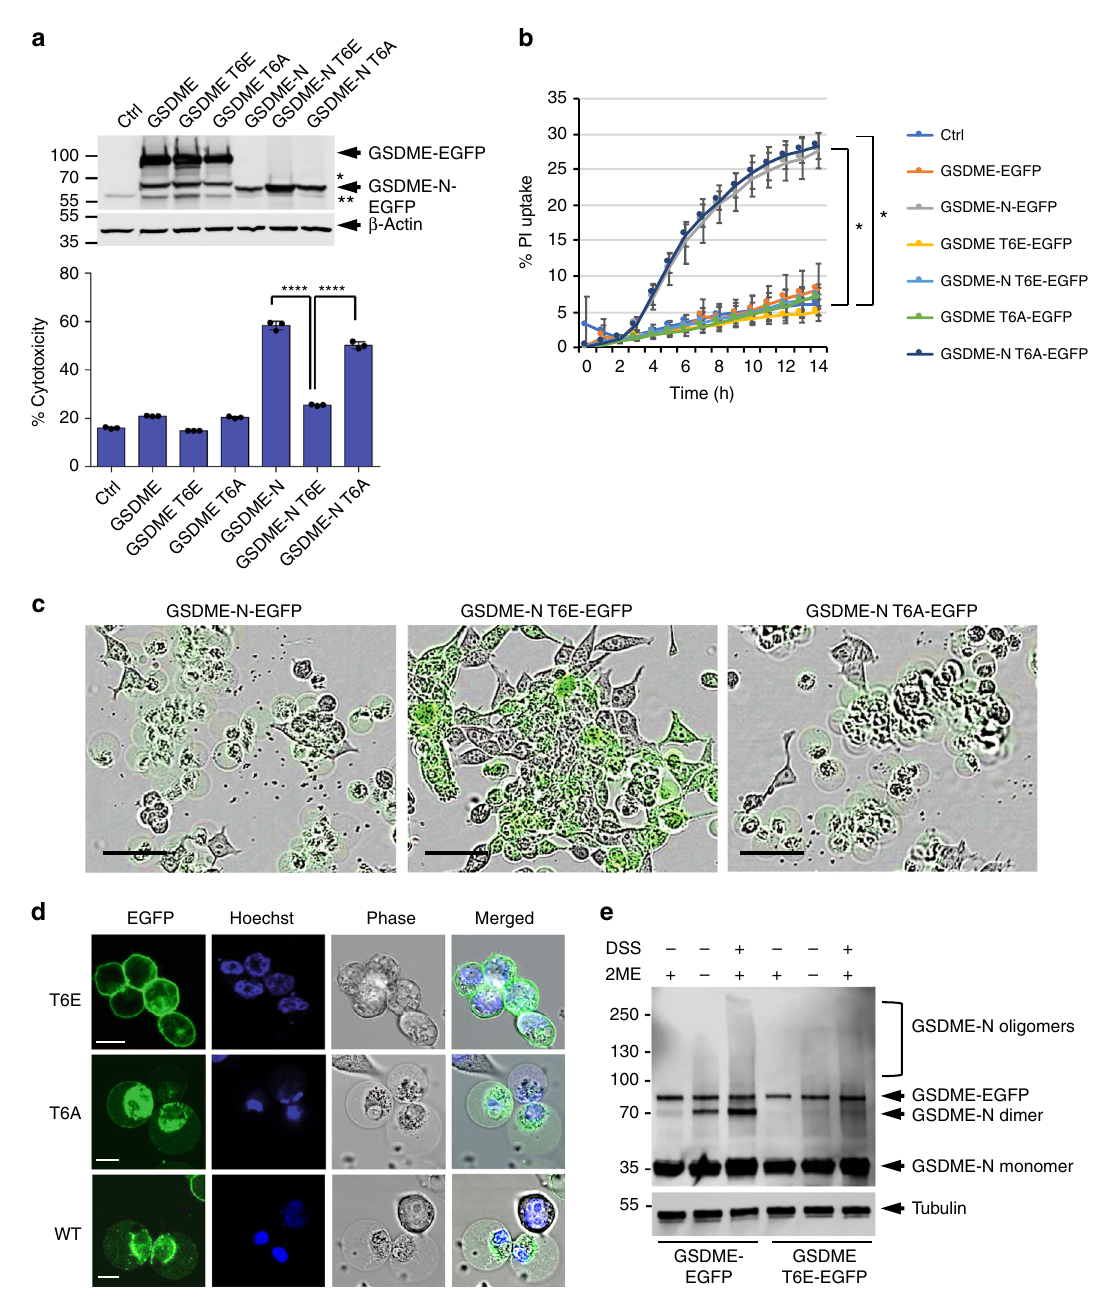
Fig. 2 T6E mutation inhibits the pyroptotic and self-oligomerization activities of GSDME. a , b Cytotoxicity and pyroptotic activity of the indicated GSDME- N constructs as measured by lactate dehydrogenase (LDH) release ( a ) or propidium iodide (PI) uptake ( b ), respectively, in 293T cells transfected with empty vector (Ctrl) or the indicated GSDME. Expression of these constructs in cell lysates is shown in ( a , top panel) as visualized by immunoblot analysis with anti-GSDME antibody. *Internal translation. **Non-speci fi c band. c Representative IncuCyte images showing pyroptosis induction in cells expressing GSDME-N-EGFP (left) or GSDME-N-T6A-EGFP (right), but not in cells expressing GSDME-N-T6E-EGFP (middle). Scale bar, 50 µ m. d Confocal images of GSDME-N-EGFP variants T6E (top panels), T6A (middle panels) and wild-type (WT; lower panels) transiently expressed in 293T cells. The perinuclear localization of WT or T6A GSDME-EGFP is largely due to the association of GSDME-N-EGFP with the mitochondria (see Fig. 4), which coalesce around the nucleus in pyroptotic cells. Scale bar, 10 µ m. e Immunoblots showing WT or T6E GSDME-N after incubation with puri fi ed cell membranes and fractionation on sodium dodecyl sulfate (SDS) polyacrylamide gel in the presence or absence of β -mercaptoethanol (2-ME), or incubation with puri fi ed cell membranes followed by cross-linking with disuccinimidyl suberate (DSS) and fractionation on SDS – polyacrylamide gel in the presence of 2-ME. Results are representative of at least three independent experiments performed in duplicate or triplicate. Error bars represent S.D. Student ’ s t -test, * p < 0.05, **** p <